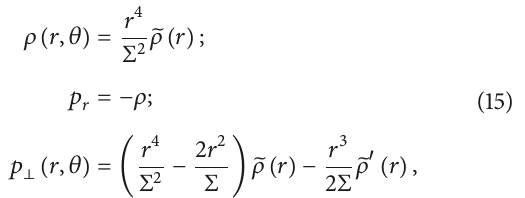
Figure 3: First type of the de Sitter interior for regular rotating